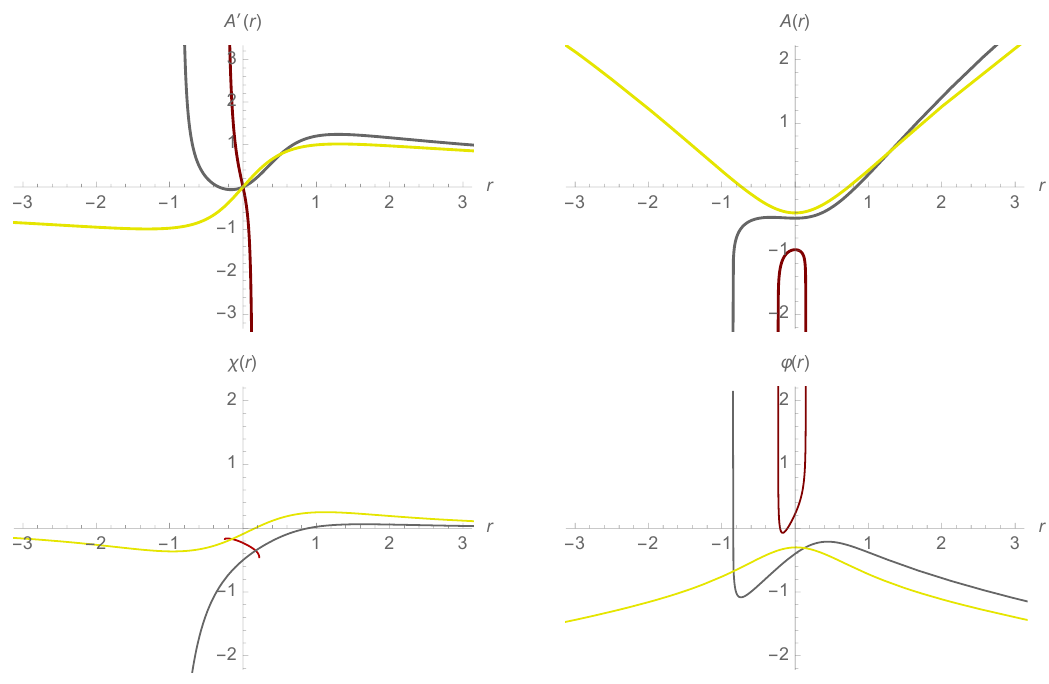
Figure 6. Examples of N = 1 Janus solutions with G 2 symmetry interpolate between SYM phases (yellow), SYM and singularity (grey), and between singularities (dark